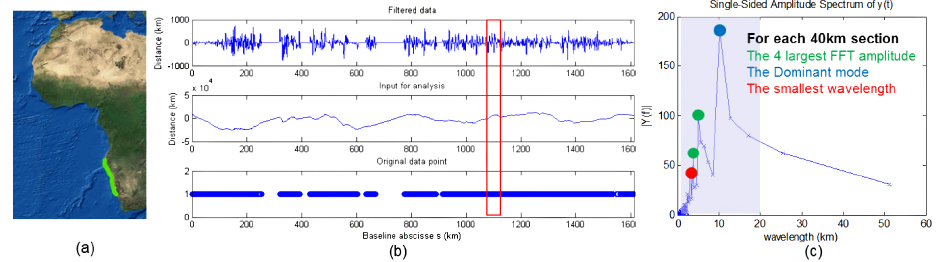
Fig. 2. Shoreline data analysis for the south portion of the Atlantic coast of Africa (a) : (b) input, filtered and original point data, (c) Fast Fourier Transformation shoreline amplitude on the 40km section indicated by the red area. The points on Fig. 2c indicate the local maxima of FFT amplitude.